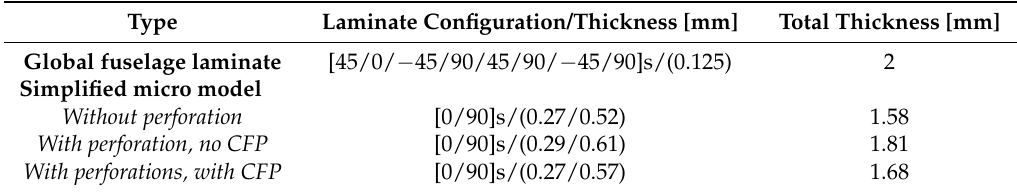
Table 2. Thickness approximation for the simplified laminate